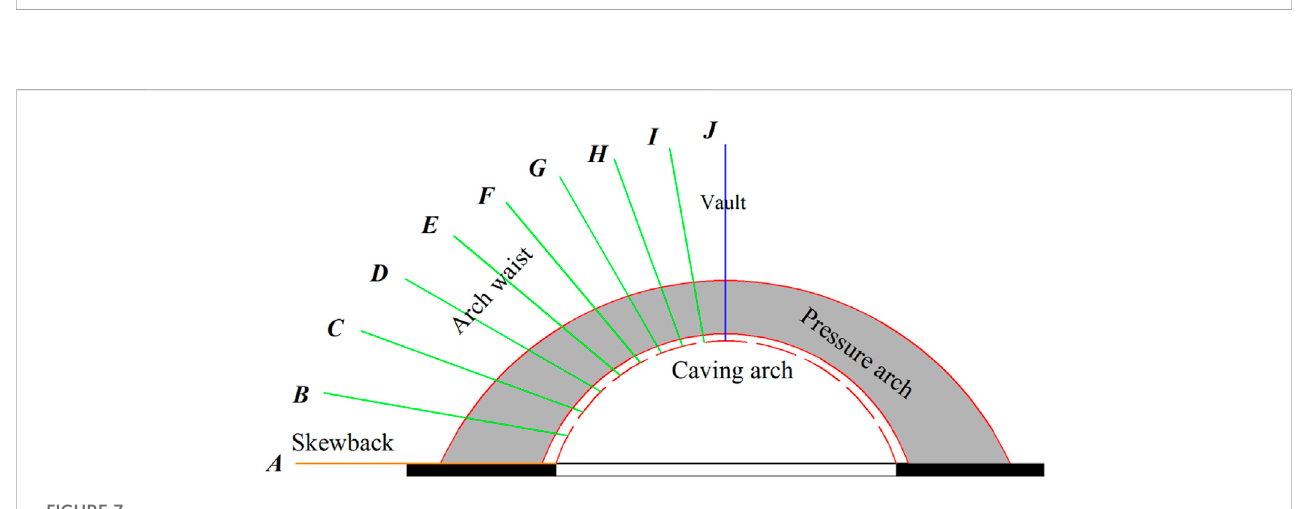
FIGURE 7 Schematic diagram of the stress examination